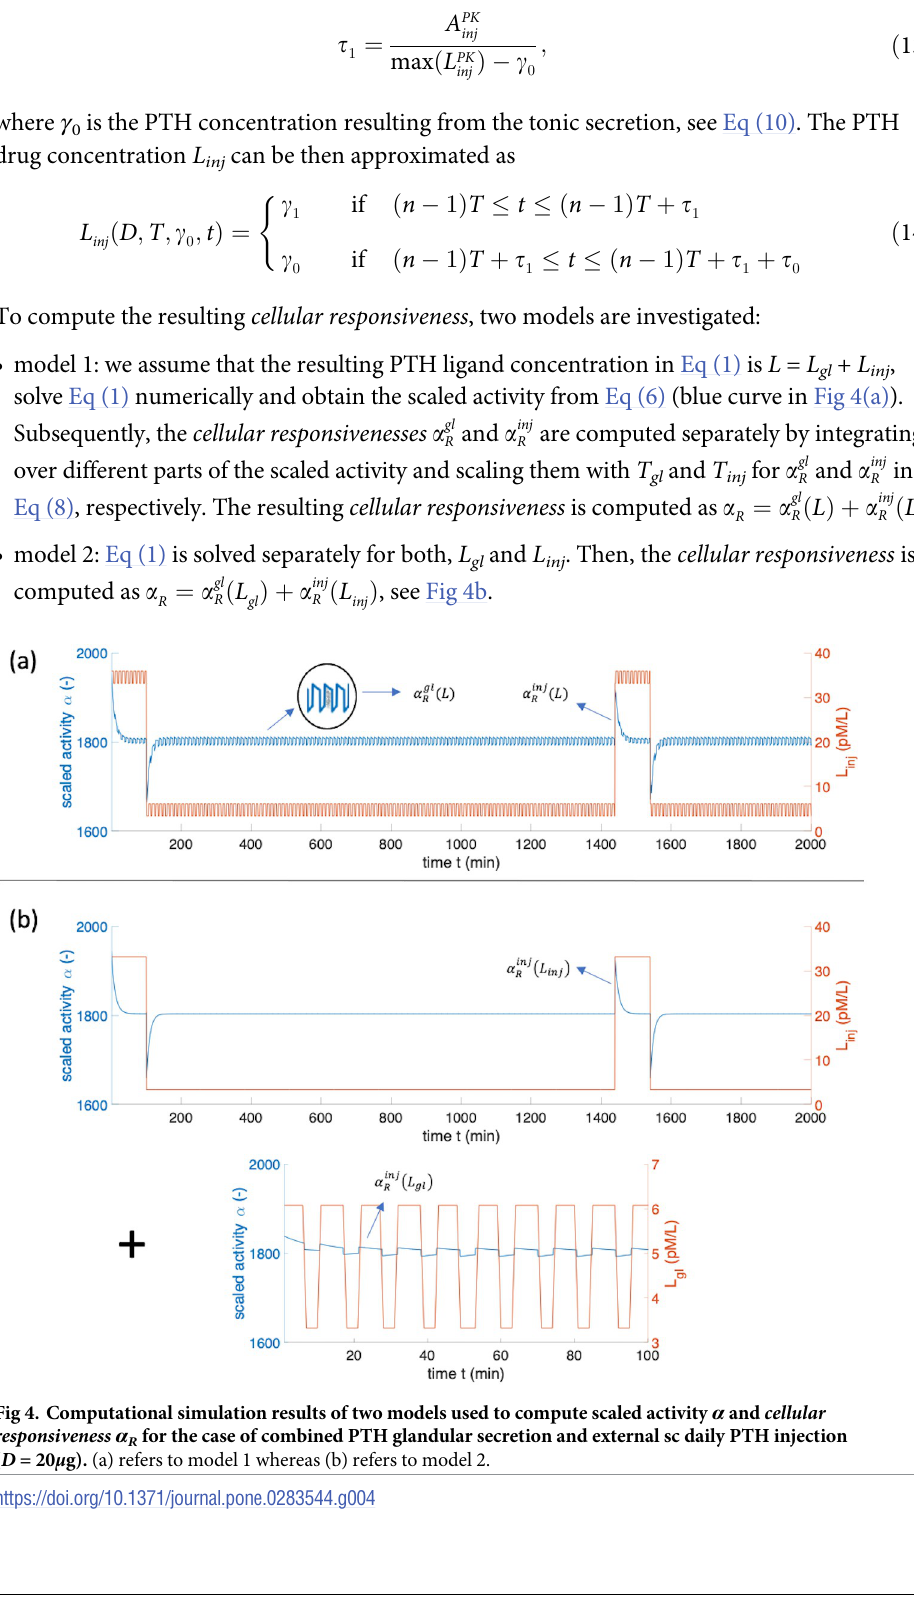
PLOS ONE | https://doi.org/10.1371/journal.pone.0283544 March 30,